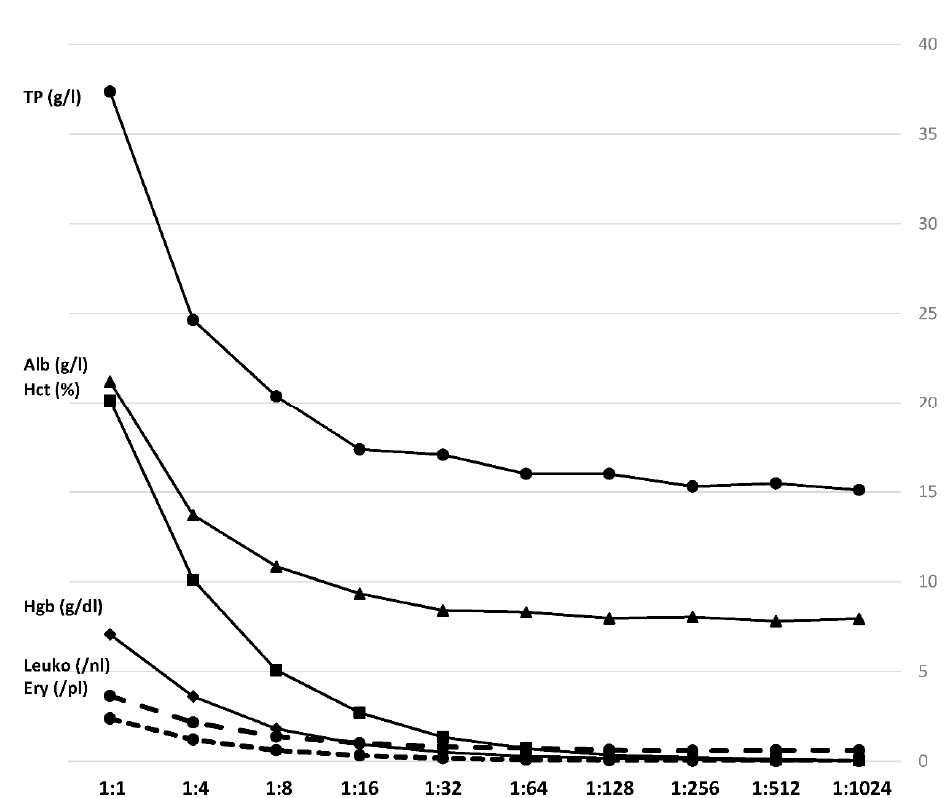
Figure 3. Laboratory-chemical parameters. Mean values of the three samples in a 10-step dilution series. Hgb: Hemoglobin; Hct: hematocrit; TP: total protein; Alb: albumin; Leuko: leukocytes; Ery: erythrocytes. Hemoglobin measurements resulted in values between 7.5 g/dL and no detectable hemoglobin among 1:512- and 1:1024-ratio-samples, whilst hematocrit was